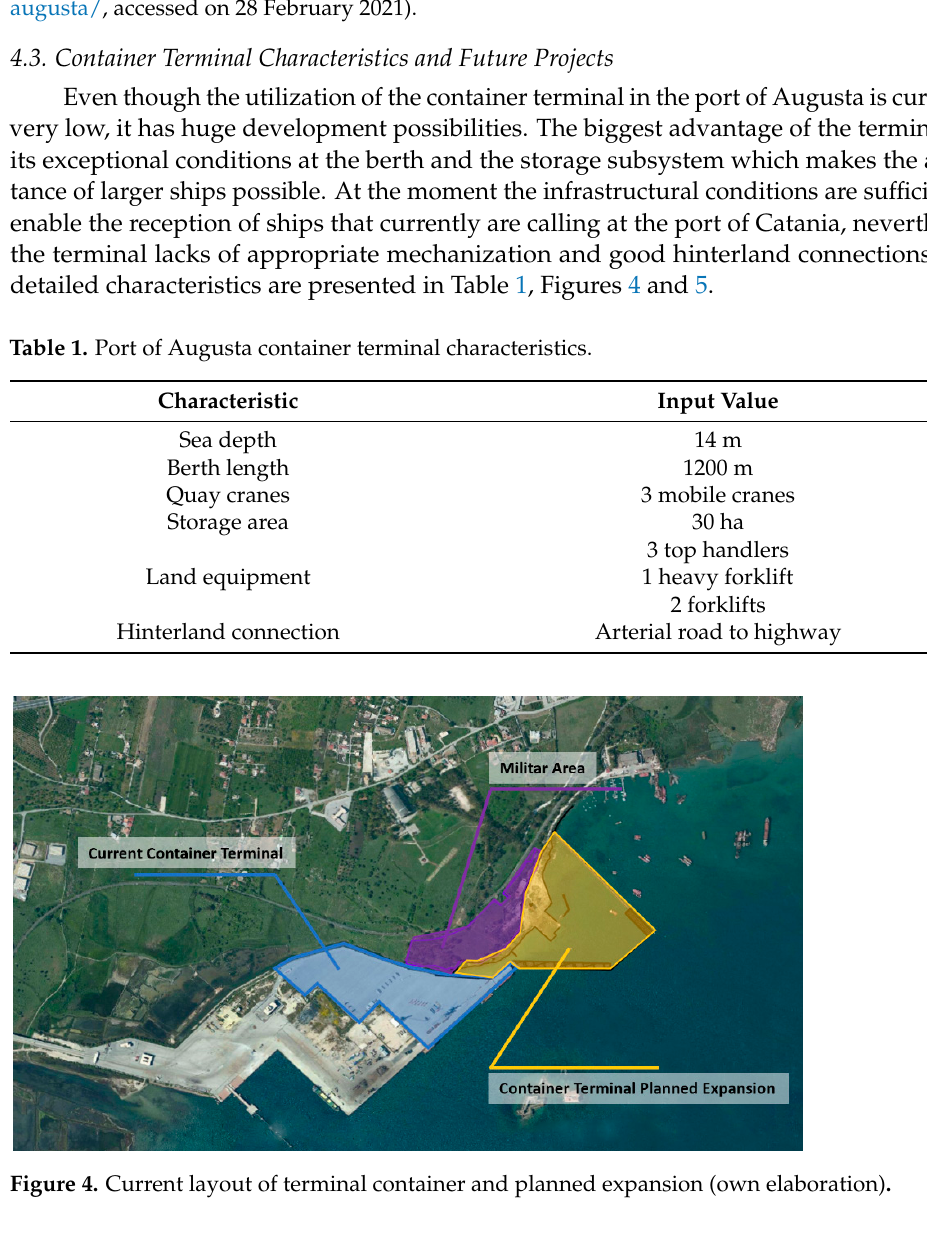
Figure 3. Port of Augusta layout (source: https://www.adspmaresiciliaorientale.it/porto-di-augusta/, accessed on 28 February 2021).